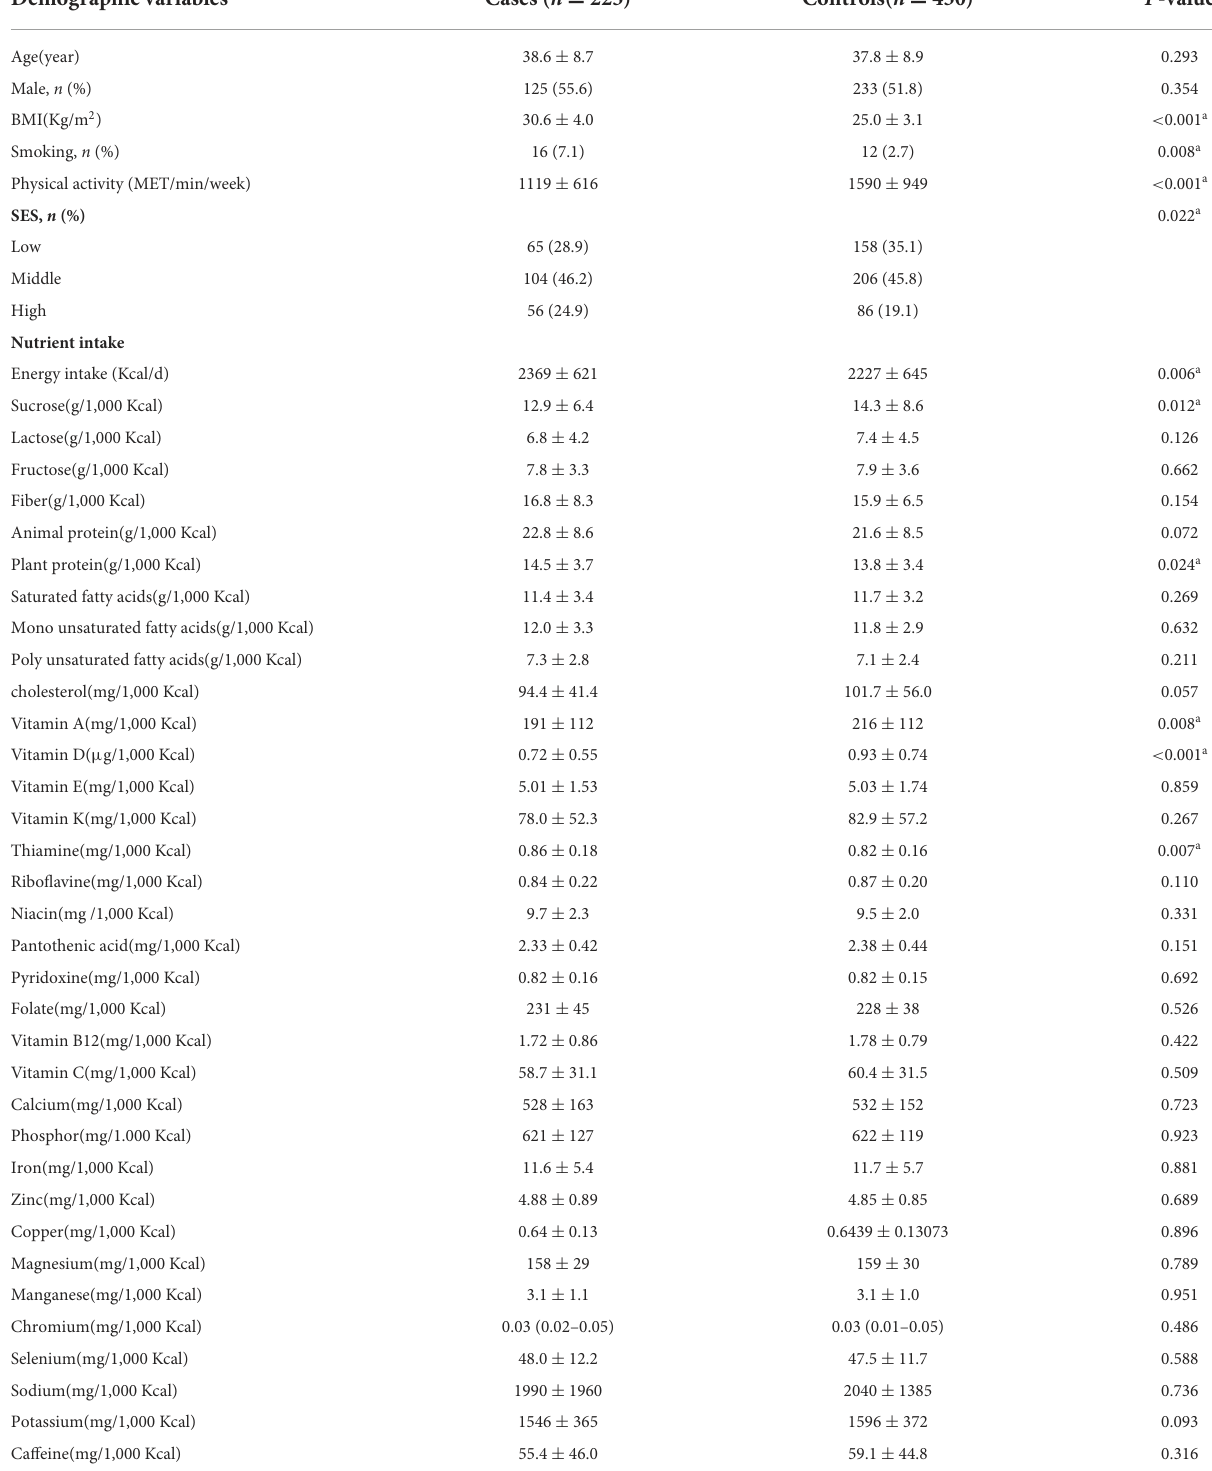
TABLE 2 Characteristics and dietary intakes among cases and controls *